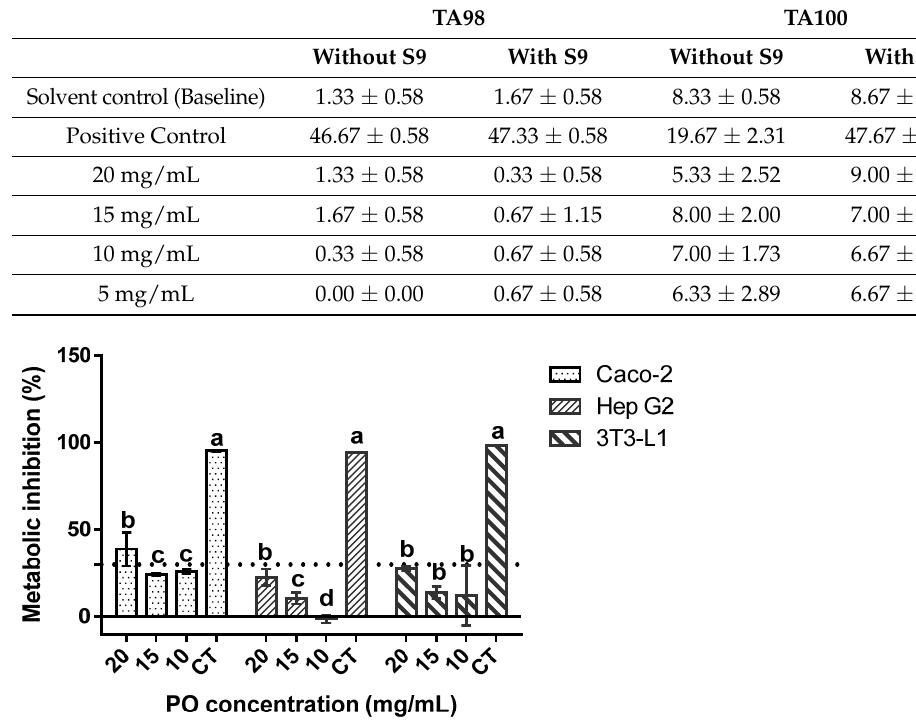
Figure 1. Pomegranate oil cytotoxicity towards the target cells lines at 20, 15, and 10 mg/mL. CT is the negative control (40% of DMSO). The dotted line represents the 30% cytotoxicity limit as defined by the (International Standard Organization (ISO), 2009). Different letters mean significant differences as determined by the one-way ANOVA test ( p < 0.05).